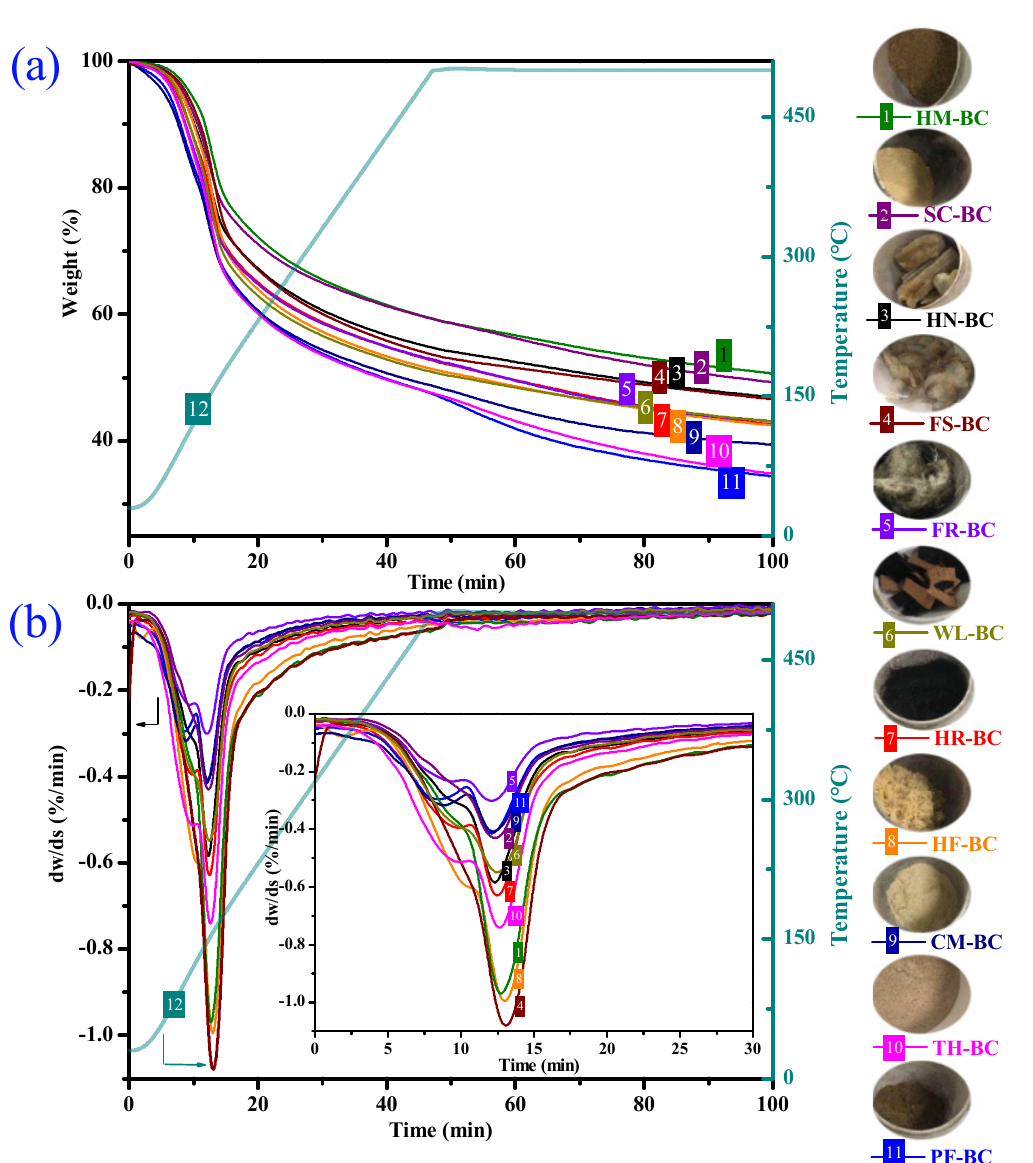
Figure 1. Thermogravimetric analysis (TGA) ( a ) and differential thermogravimetric analysis (DTG) ( b ) curves for the pyrolysis of animal-keratin-wastes biochars (AKWs-BC) and TH-based biochar (TH- BC).